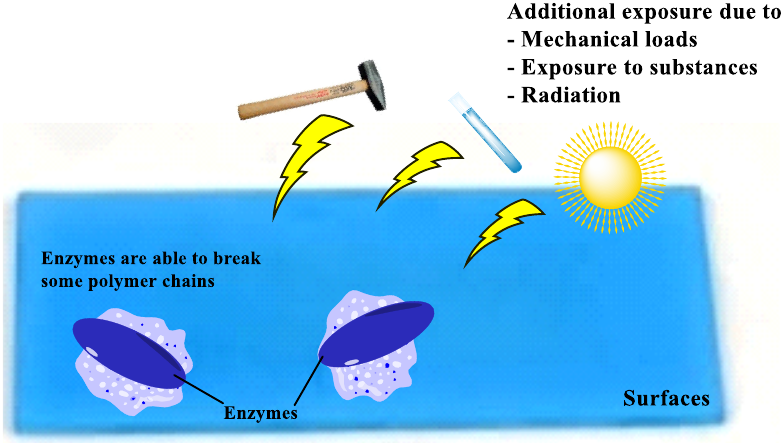
Figure 1. Polymers biodegradation: enzyme attack on plastic surface. Gelatin is a compound formed by collagen denaturation. The composition of gelatin differs from that of undenatured collagen in terms of its amino acid composition. Gelatin consists of completely denatured protein with Mw = 50–150 kDa [14,15]. Chemical de- naturation is performed by hydrolysis catalyzed by enzymes, acids, or bases. Thermal denaturation takes place under mild conditions by heating the collagen in neutral or slightly acidic conditions to about 40 ◦ C. The transition is clear and occurs in a few minutes within a small temperature range. Only the hydrogen bonds and hydrophobic bonds are broken, which helps to stabilize the collagen helix, causing the dissociation of collagen fibers into tropocollagen molecules. The intramolecular bonds between the three helix chains are broken, resulting in a mixture of proteins and amino acids called gelatin